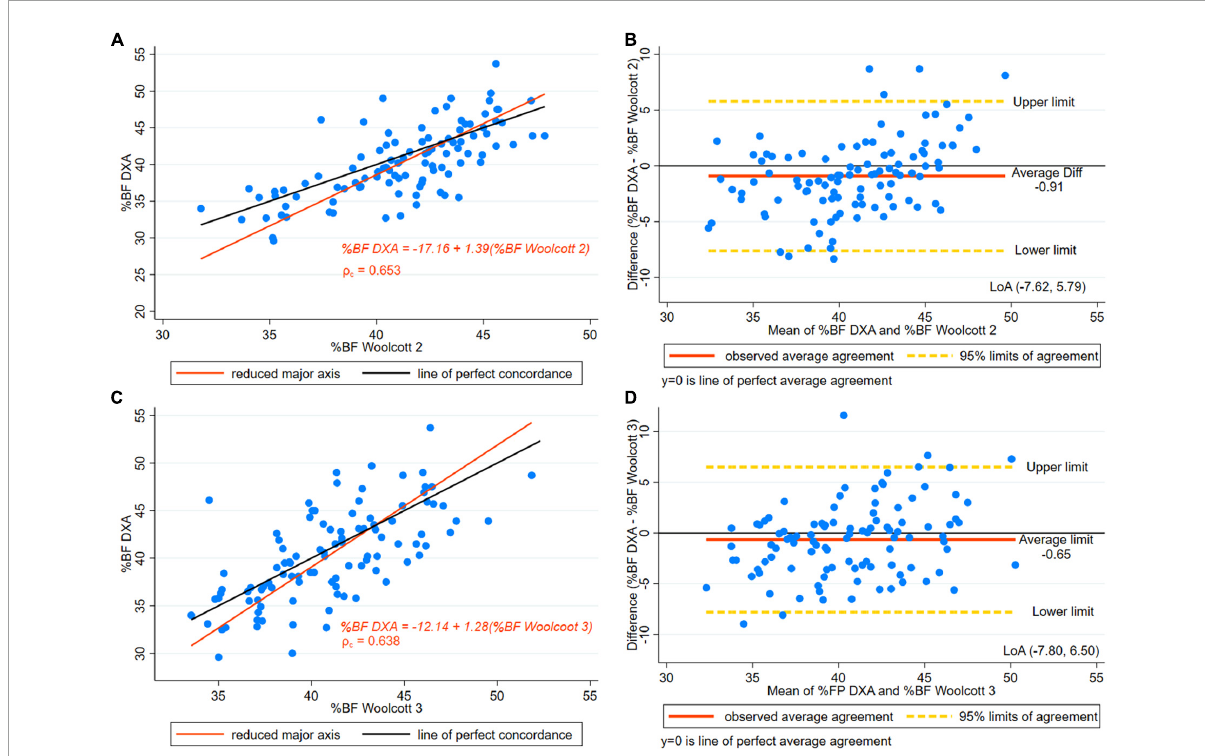
FIGURE4 (A) Concordance plot of body fat percentage (BF%) estimated by DXA and Height 3 /Waist x Weight Woolcott’s equation (Woolcott Equation 2). Pearson’s correlation coefficient (r) and Lin’s concordance correlation coefficient ( ρ c ) for women with height > 145 cm. (B) The Bland-Altman plot is presented along with the and Limits of Agreement (LoA) for BF% estimated by DXA and Height 3 /Waist x Weight Woolcott’s (Woolcott Equation 2) for women with height > 145 cm. (C) Concordance plot for BF% estimated by DXA and Waist /Height Woolcott’s equation (Woolcott Equation 3) in women with height > 145 cm. (D) The Bland-Altman plot is presented along with the LoA for BF% estimated by DXA and Waist/Height Woolcott’s equation (Woolcott Equation 3) in women with height > 145